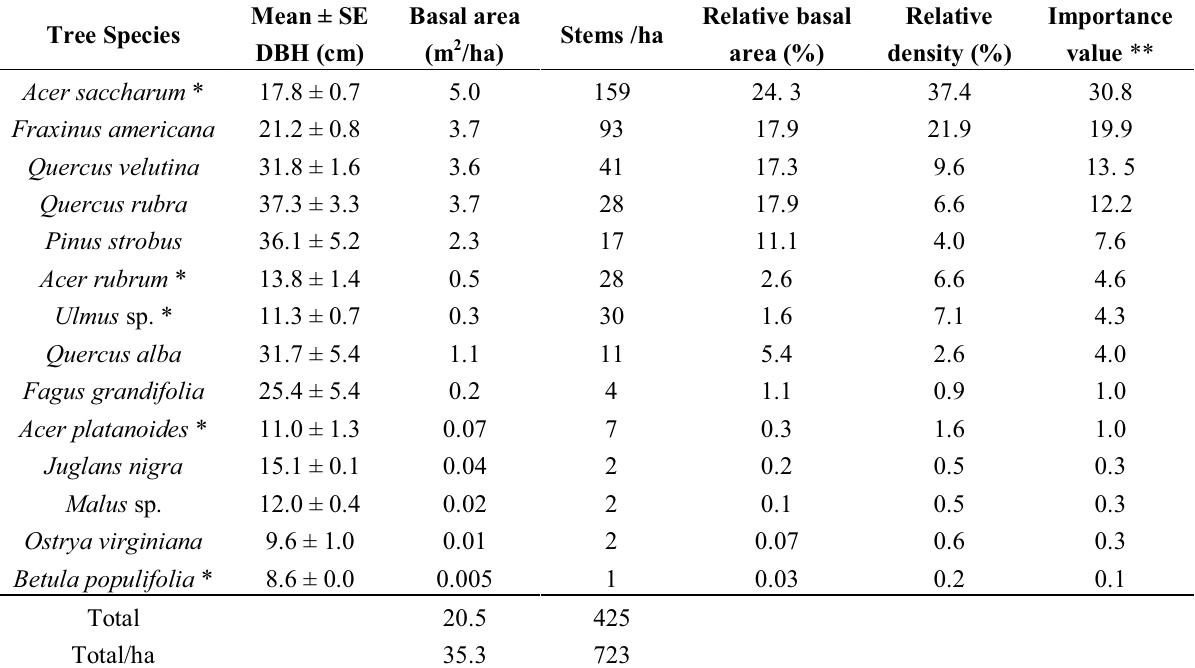
Table 3. Mean diameter, basal area, density, and importance values for trees sampled in